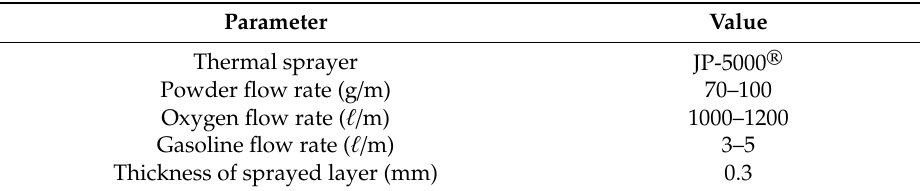
Table 2. Conditions of HVOF coating.